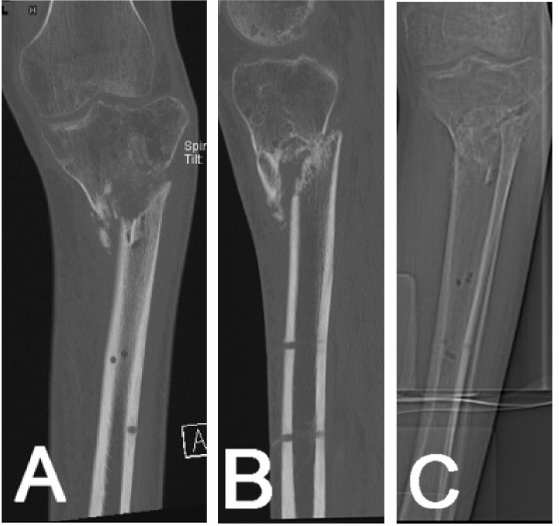
Figure 3. Conventional CT scan to plan deformity correction in a displaced proximal tibial fracture— 2D AP view ( A ) and lateral view ( B ) showing translation and varus deformity. Scanogram from the same patient in AP view ( C ).